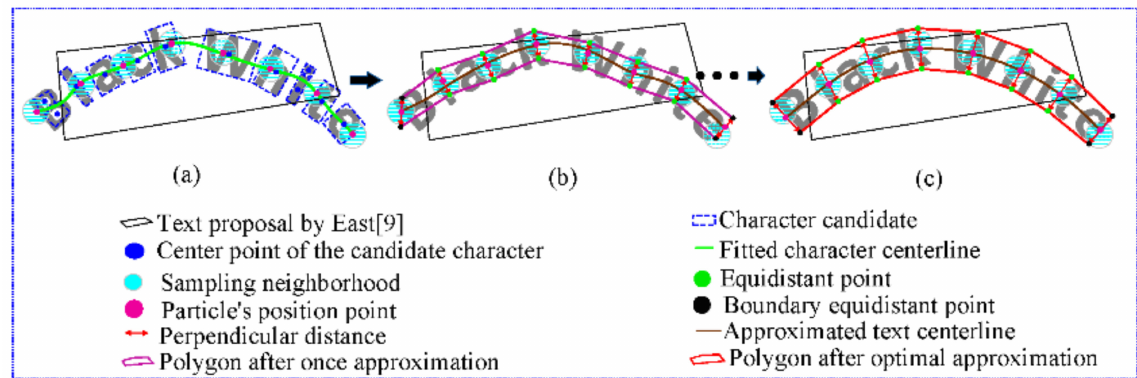
Figure 2. The framework of the PSO-TSA algorithm, ( a ) particle initialization process, ( b ) generating polygon by once approximation, ( c ) generating polygon by optimal